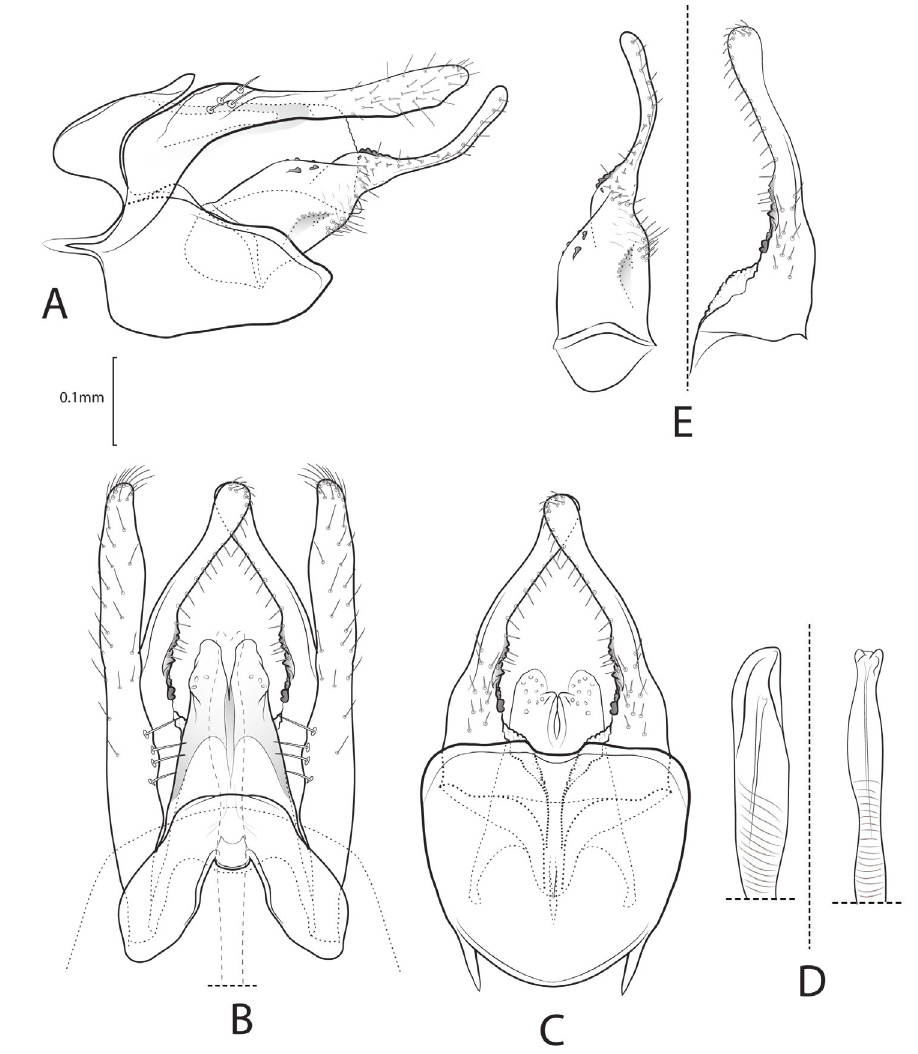
Figure 5. Xiphocentron ( Antillotrichia ) rhamnes Schmid, 1982, adult, ♂ , genitalia A left lateral B dorsal C ventral D phallus apex, left lateral and dorsal E detail of right inferior appendage mesal surface, lateral, and ventral